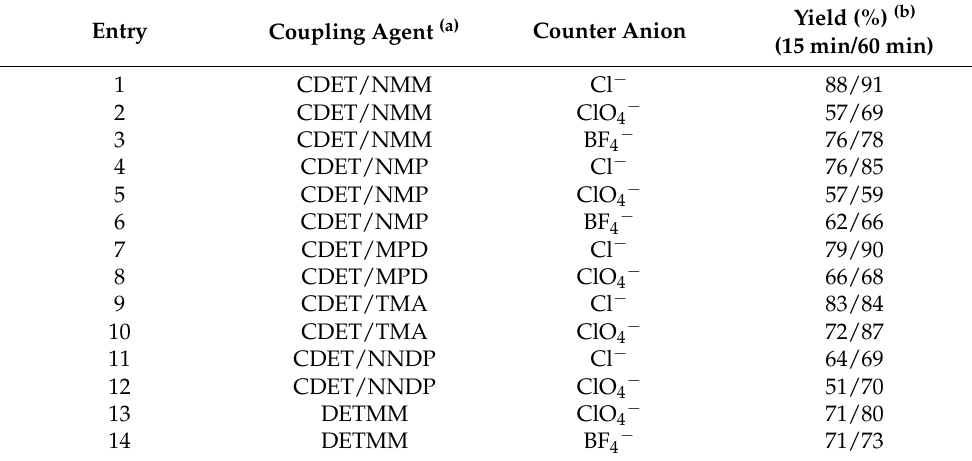
Table 2. Condensation reaction of I and II in the presence of CDET/ tert -amine with different counter